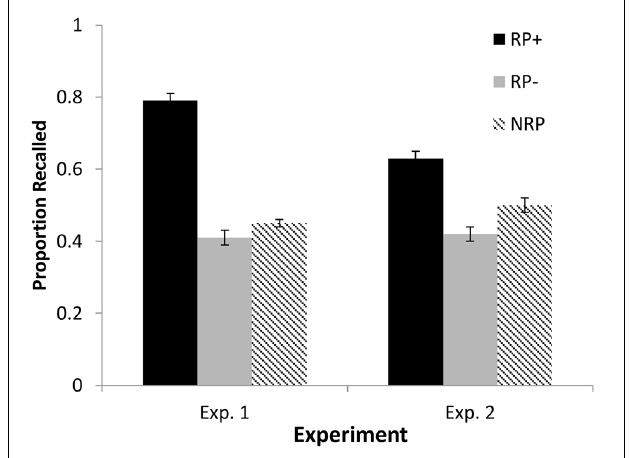
FIGURE 1 | Final recall test performance for each item type in Experiments 1 and